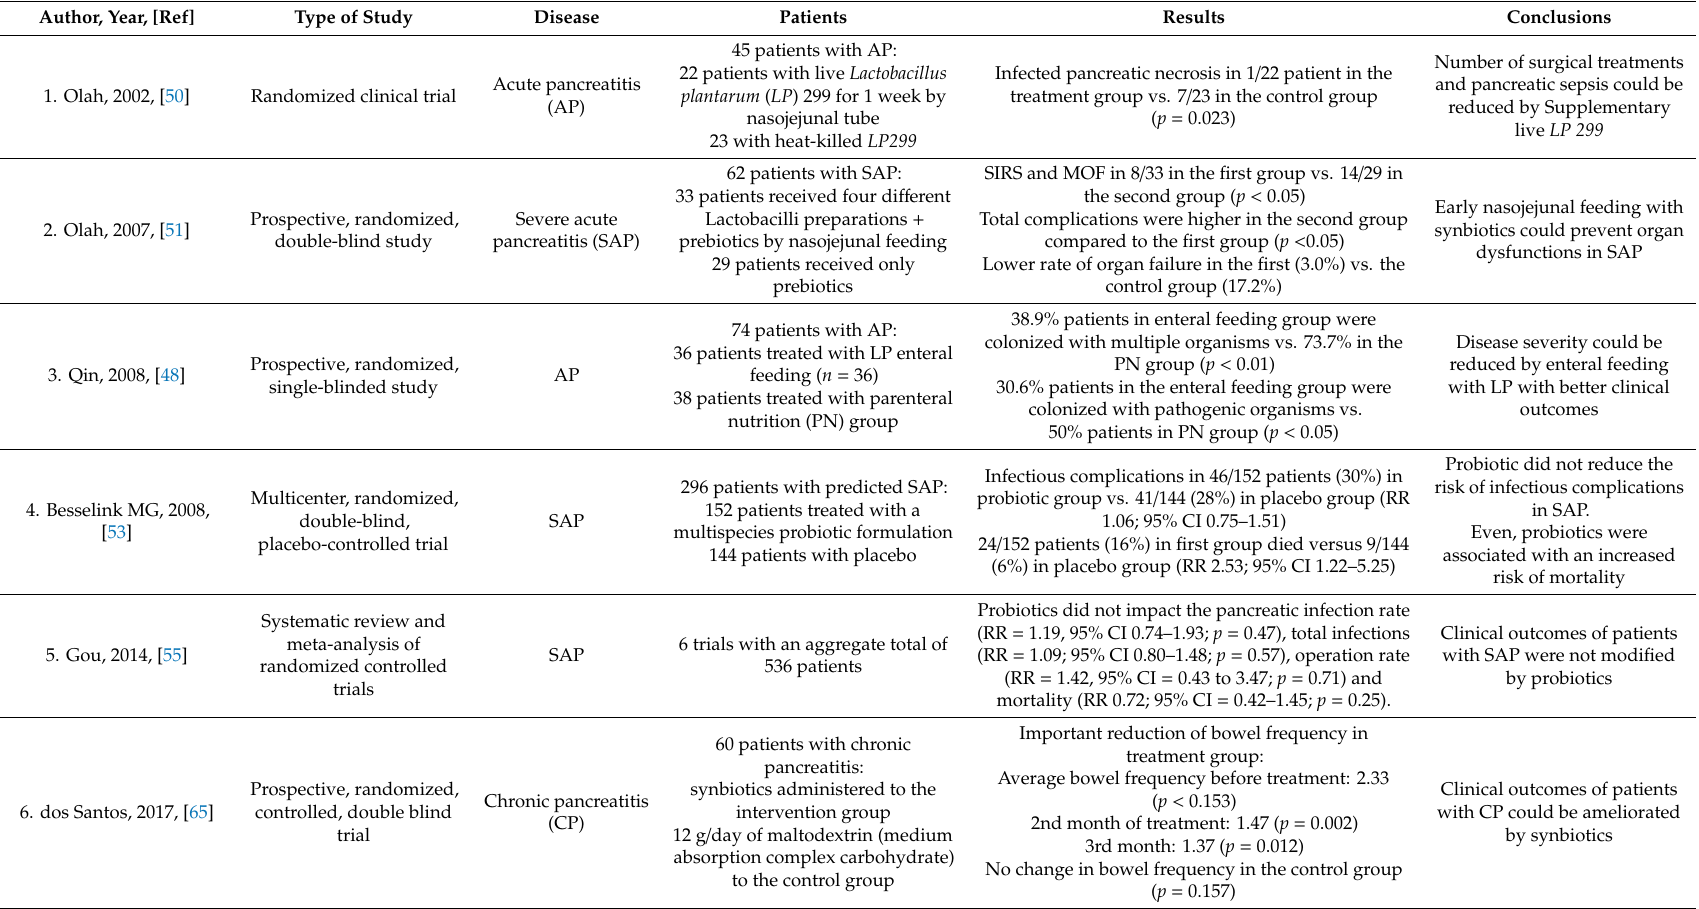
Table 1. Randomized clinical trial about the use of probiotics, prebiotics or synbiotics in acute and chronic